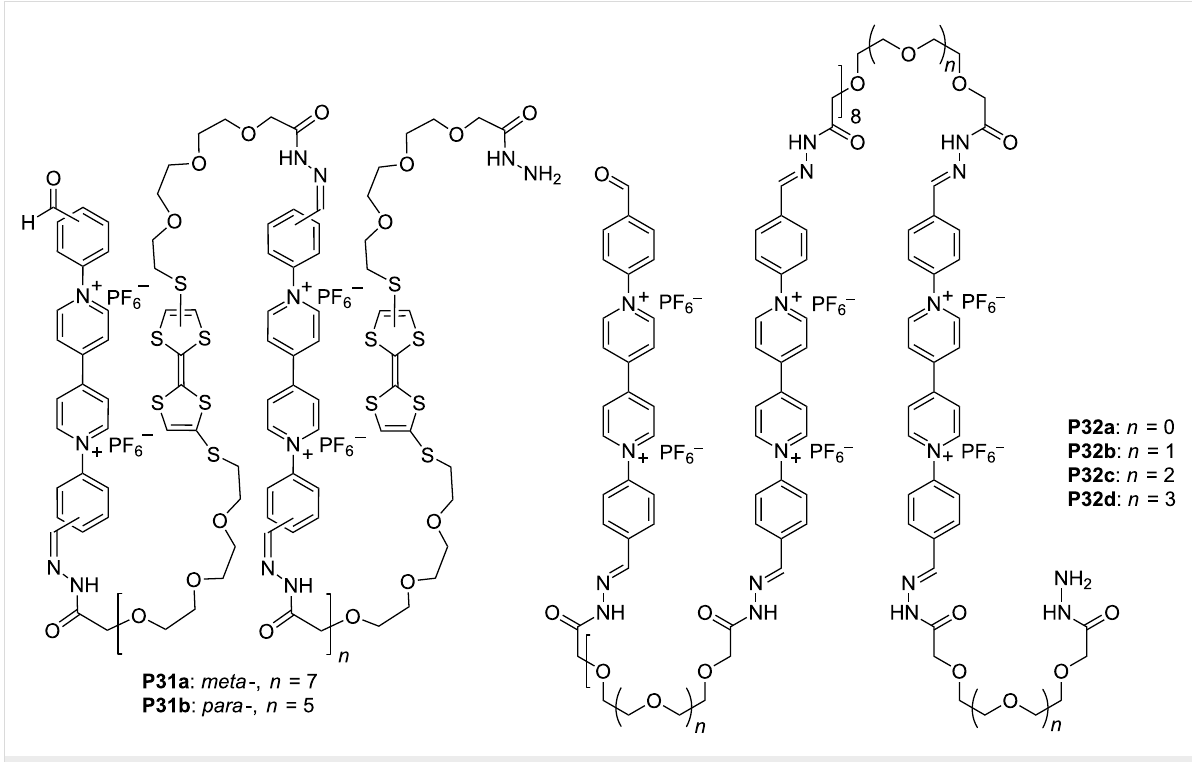
Scheme 16: The structures of polymers P31a,b and P32a–d .